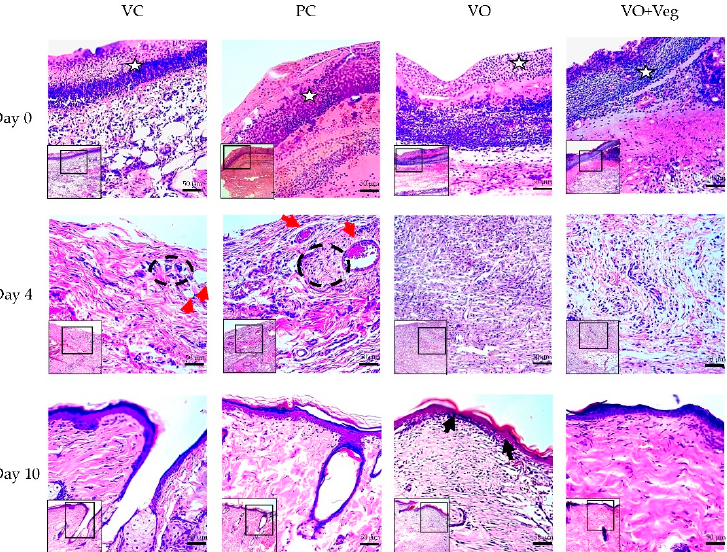
Figure 7. Histological microscopic representative images of the wound healing process of the experimental groups VC, PC, VO, and VO + Veg. Skin sections demonstrate dermis and epidermis stained with hematoxylin and eosin at 10× (smallest figure) and 20× (larger figure) magnifications. The white stars indicate the granulation tissue region. Red arrows indicate perivascular inflammatory infiltrate in the upper dermis, with dotted black demarcation lines of regions rich in inflammatory cells. On day 10, the epidermis layer (upper edge) is highlighted, with a keratin-rich stratum corneum, mainly in the group, indicated by the black arrows.